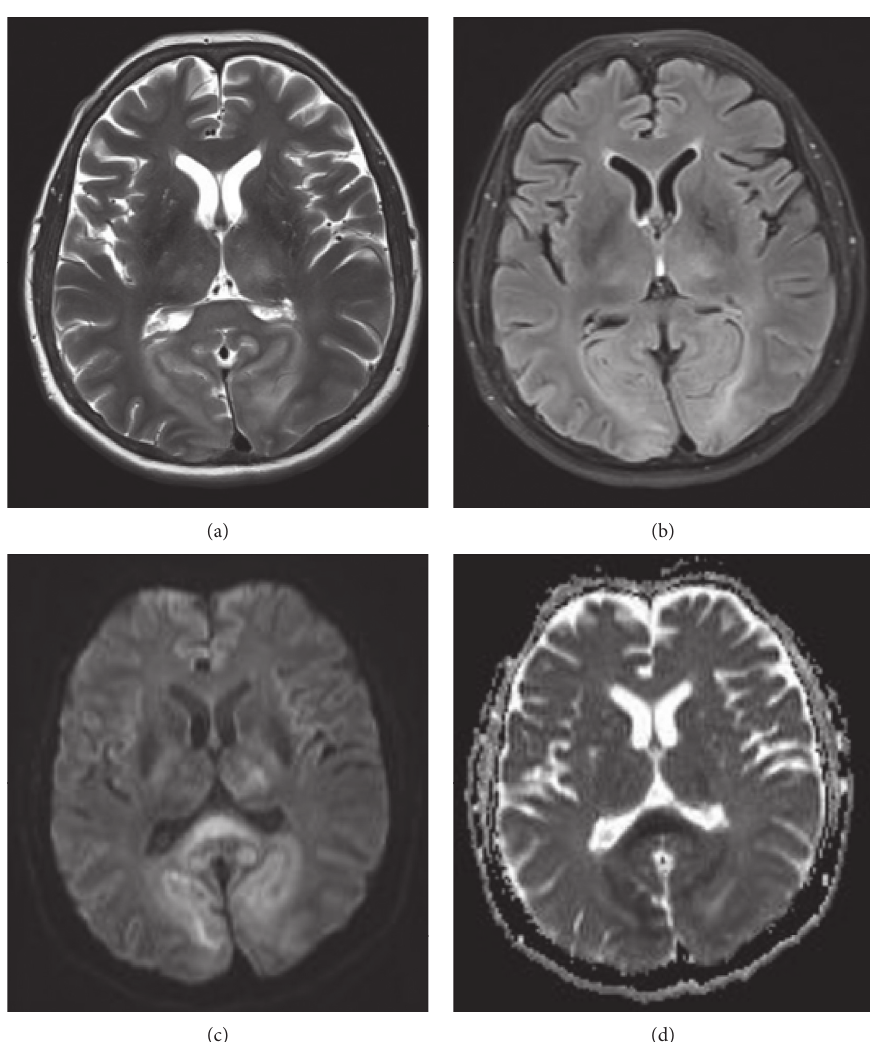
Figure 2: Brain MR (axial images) obtained 2 days after angiography. T2 and FLAIR images (a, b) show bilateral symmetrical hyper- intensities in basal ganglia, in parieto-occipital cortex, and in splenium of corpus callosum. DWI and ADC images (c, d) demonstrate restricted diffusion in the same